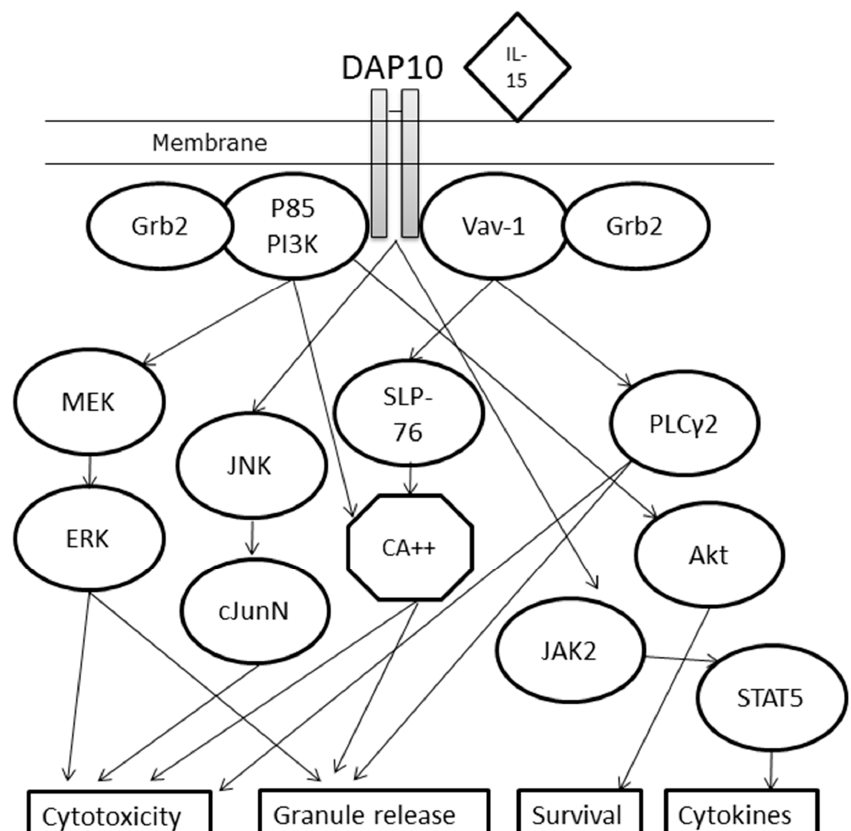
Figure 2. Diagram of the signaling pathways of the activated NKG2D receptor complex through DAP10. Cytokines are presented in diamond shapes, signaling proteins in ovals, ions in hexagons and cellular effects in rectangles. DAP10 (DNAX-activating protein of 10 kDa); IL-15 (interleukin 15); Grb2 (Growth factor receptor-bound protein 2); P85 PI3K (P85 subunit of PhosphoInositide 3-Kinase); Vav-1 (vav guanine nucleotide exchange factor 1); MEK (Mitogen-activated protein kinase kinase); ERK (Extracellular signal-Regulated Kinase); JNK (c-Jun N-terminal protein Kinases); cJunN (c-Jun N-terminal kinase-1); SLP-76 (SH2 domain-containing leukocyte phosphoprotein of 76kDa); CA++ (Ca 2+ ion); PLC γ 2 (Phospholipase C γ -2); Akt (Protein Kinase B); JAK2 (Janus kinase 2); STAT5 (Signal Transducer and Activator of Transcription